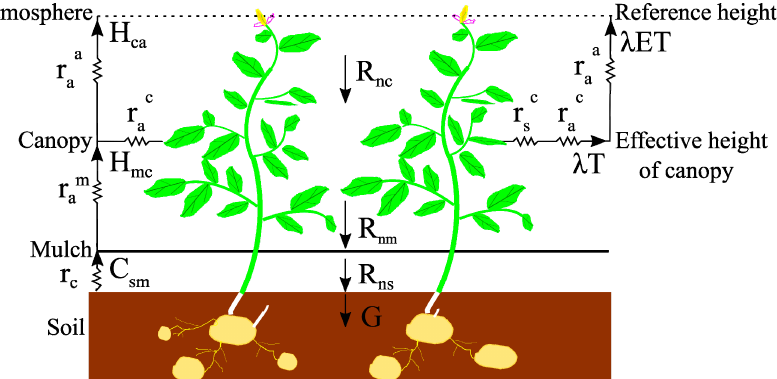
Figure 2. Schematic diagram of energy transport in a potato field with plastic film mulch ( R nc , R nm , and R ns are the net radiations absorbed by the plant canopy, the plastic film mulch, and the soil surface, respectively; H ca is the sensible heat flux from the plant canopy to the atmosphere; H mc is the sensible heat flux from the plastic film mulch to the plant canopy; C sm is the conduction from the soil surface to the plastic film mulch; G is the soil heat flux at the soil surface; λ T is the latent heat flux of the plant canopy; λ ET is the latent heat flux of complete canopy; r c s is the bulk stomatal resistance of the plant canopy; r c a is the bulk boundary layer resistance of the vegetative elements in the plant canopy; r a a is the aerodynamic resistance between the plant canopy and the reference height; r m a is the aerodynamic resistance between the plastic film mulch and the plant canopy; r c is the thermal contact resistance between the plastic mulch and soil).